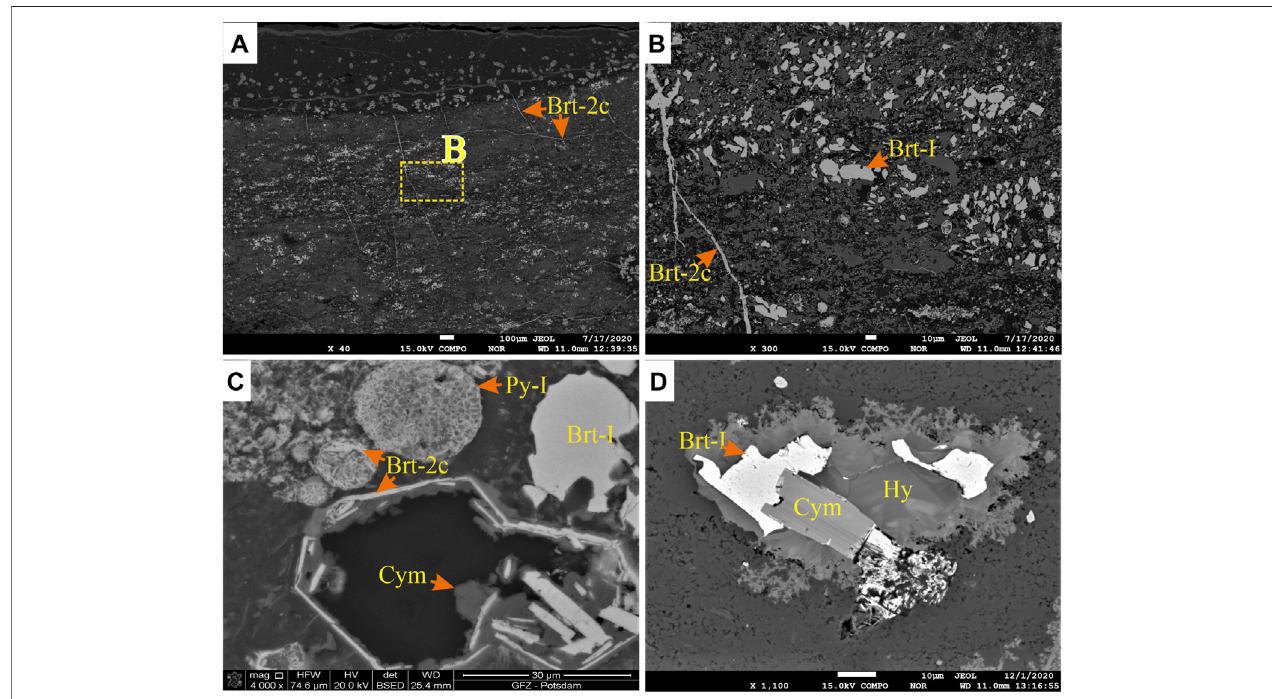
FIGURE 7 | (A) BSE image of barite crystals with barite veins (Brt-2c). The orange box depicts BSE image B. (B) BSE image of barite vein (Brt-2c) crosscutting earlier formed barite grains, including microcrystalline barite (Brt-1). (C) SEM BSEimage of barite replacement of framboidal pyrite (Py-I) by Brt-2c. Cymrite (Cym) grows intheporespacesleftbythedissolutionofpyrite(Py-2)grains. (D) BSEimageofBrt-Iintergrowthwithcymrite(Cym)andwithinsubhedralanddendritichyalophane(Hy).